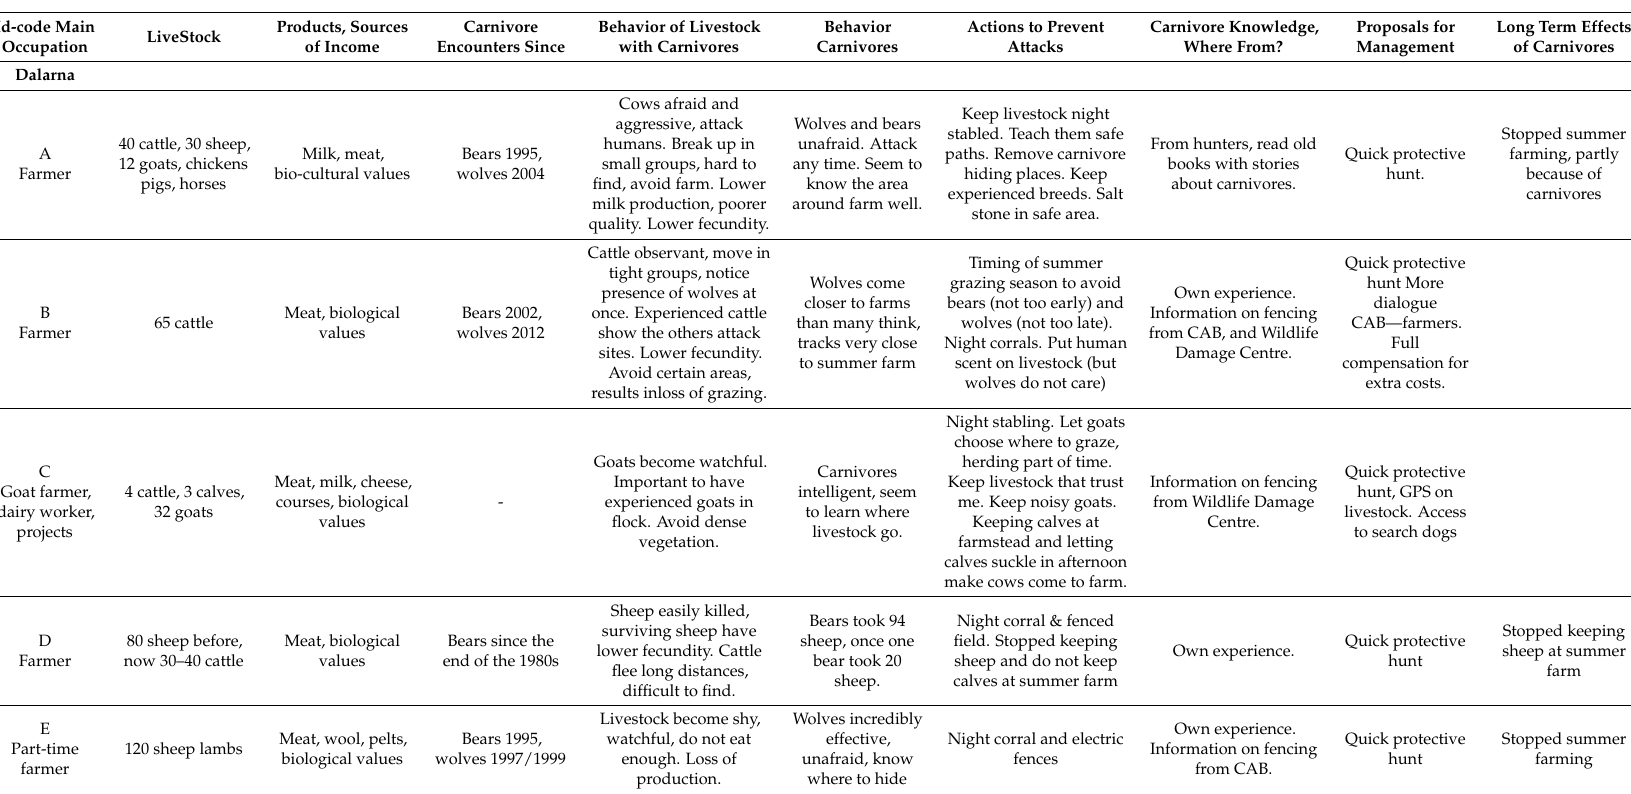
Table A1. Experiences from carnivore encounters among the interviewed summer farmers. Id-code stands for farmer interviewed. The columns contain basic information about livestock kept and sources of income, year of first encountere with carnivores at the summer farm, observations on livestock behavior in response to carnivore presence and observations about carnivore behavior. The four right columns present which preventive actions summer farmers have taken, where they gained knowledge about preventive measures, proposals for future management and consequences following the presence of carnivores. CAB = County Administrative